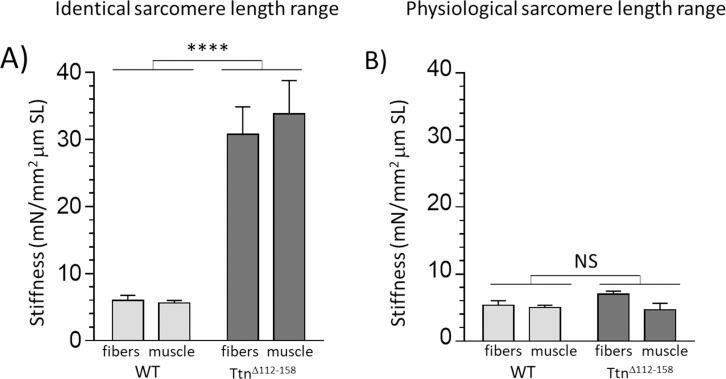
Passive muscle stiffness at the physiological sarcomere length range.Passive stiffness in Ttn∆112-158 and WT EDL 5th toe muscle at an identical sarcomere length range (A) and at the physiological sarcomere length of each genotype (B). Data in A represent the average stiffness in the sarcomere length range 2.45–2.75 μm (data from Figure 5C, inset) and data in B represent the average stiffness in the sarcomere length range 2.35–2.85 μm for WT and 2.12–2.55 μm for Ttn∆112-158, representing the physiological sarcomere length range determined in Figure 8D. It is notable that within the physiological sarcomere length range (B) passive stiffness of the two genotypes is the same. (No differences between results of single fibers and whole muscle.). Legends for the supplementary figures.